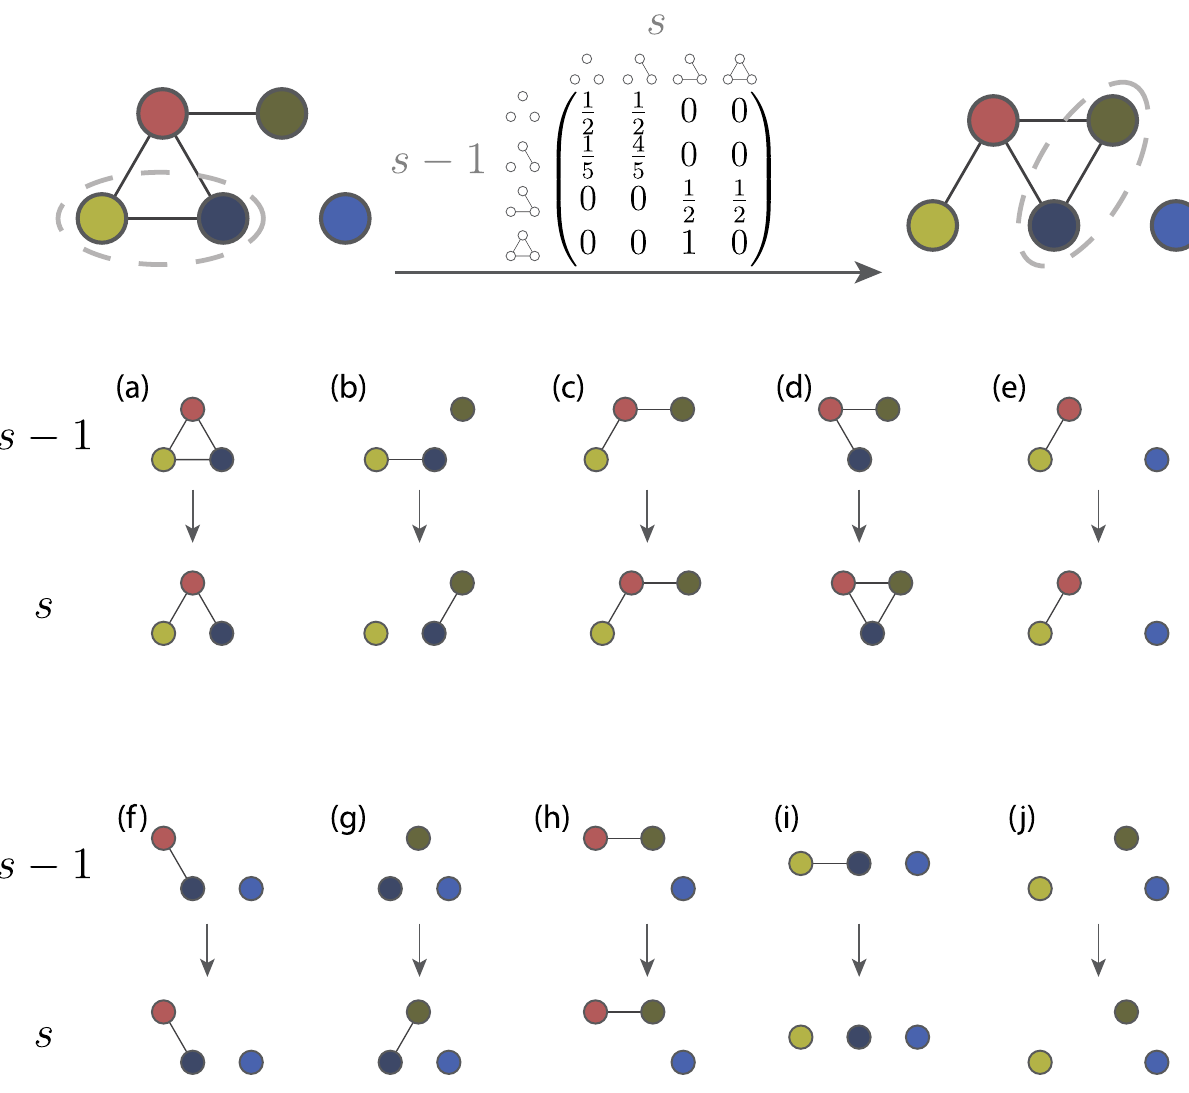
T ( s ) , shown top centre, can be computed from Figure 2. An illustration of how the empirical transition matrix evolution of the network G ( s − 1 ) shown top left, with links at time s − 1 , to G ( s ) shown top right, with links (cid:31) at time s . When the states are only characterised by the number of links of the three-node combinations, M 4 , for illustrative purposes, there are four possible states being denoted by m i ( i = 0, 1, 2, 3 ) of Fig. 1. The subscript i represents the number of the links i in the graphlet m i , so m 0 is the triplet with zero links, m 1 is a triplet with one 5 = 10 ways of choosing 3 nodes for a set of 5 nodes, and the evolution of all ten link and so on. There are 3 (cid:30) (cid:31) triplets are shown in the remaining rows in the figure above. For instance, the subgraph induced by a triplet (a) is the triplet m 3 . This triplet loses an link in the next graphlet, so the same node triplet is now associated with the T two link triplet m 2 . This change, therefore, contributes to the 32 entry. As this is the only induced subgraph T T (graphlet) in the earlier G ( s − 1 ) graph which is isomorphic to the m 3 triad, this means 32 = 1 while 3 j = 0 (cid:31) for j = 0, 1, 3 . On the other hand, the double link m 2 triad appears twice as an induced subgraph of node triplets (cid:31) (cid:31) in G ( s − 1 ) , namely (c) and (d). These triplets have two different triads in G ( s ) leading to two non zero entries T T T M in the 8 of Fig. 1 in our 2 j row, 22 = 23 = 1 / 2 . Note we use (cid:31) (cid:31) (cid:31) holder network 51 . The nodes are shareholders in Turkish companies and two shareholders are linked if they both hold shares in the same company in one year. The snapshots in the Turkish companies temporalShareholder network, G ( s ) , are for consecutive years. The second data set is a Wikipedia Mathematicians network. Nodes are pages corresponding to biographies of mathematicians in Wikipedia and two nodes are connected in one snapshot G ( s ) if there is a hyperlink (in either direction) between the two pages at the time the data is taken 52 . The third temporal network is constructed from college message data. In this case the nodes are students and an edge in a snapshot indicates that the students exchanged a message within the interval associated with that